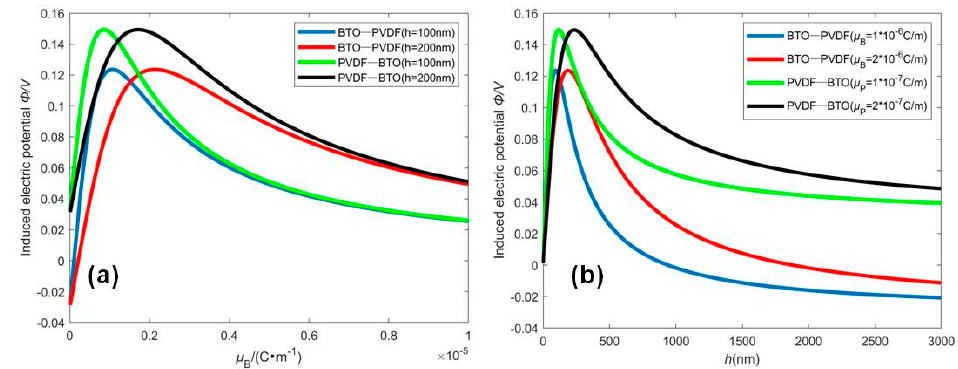
Figure 5. The variation of the induced electric potential of FGM sensors subjected to the mechanical loading 𝑞 = 0.01𝑛𝑁/𝑛𝑚 vs. ( a ) the flexoelectric coefficient and ( b ) the beam thickness.